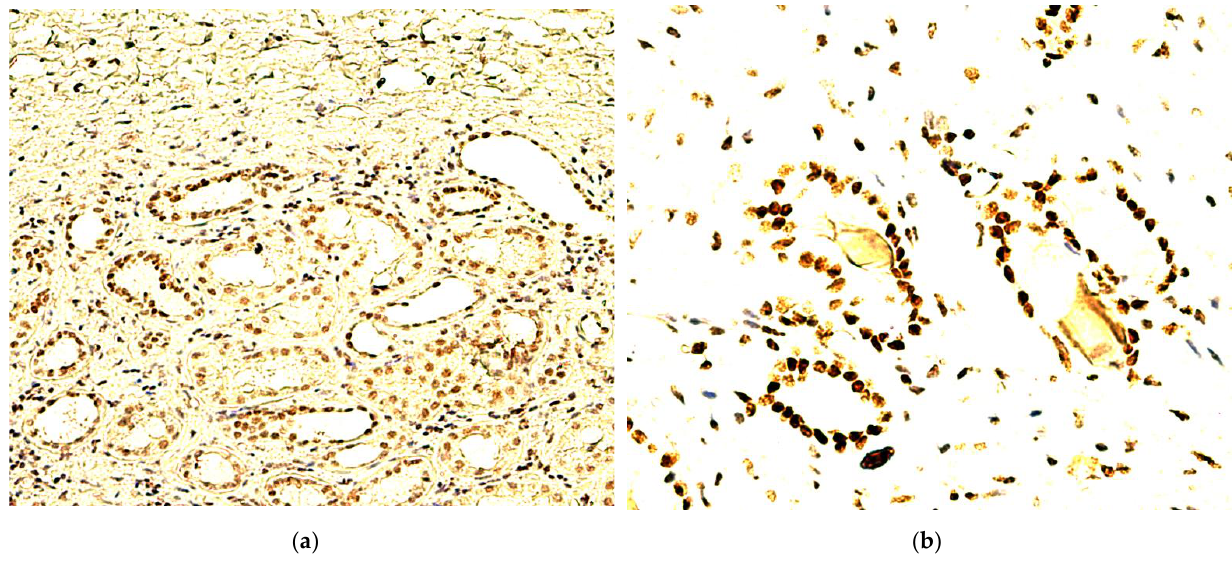
Figure 3. Tumor-adjacent healthy renal tissue TD-staining patterns. ( A ) 200x, large number of proximal and distal tubular structures, showing weak to moderate nuclear TD-positivity, bordering TD-negative RCC tumor tissue; ( B ) 400x, high-intensity tubular staining.